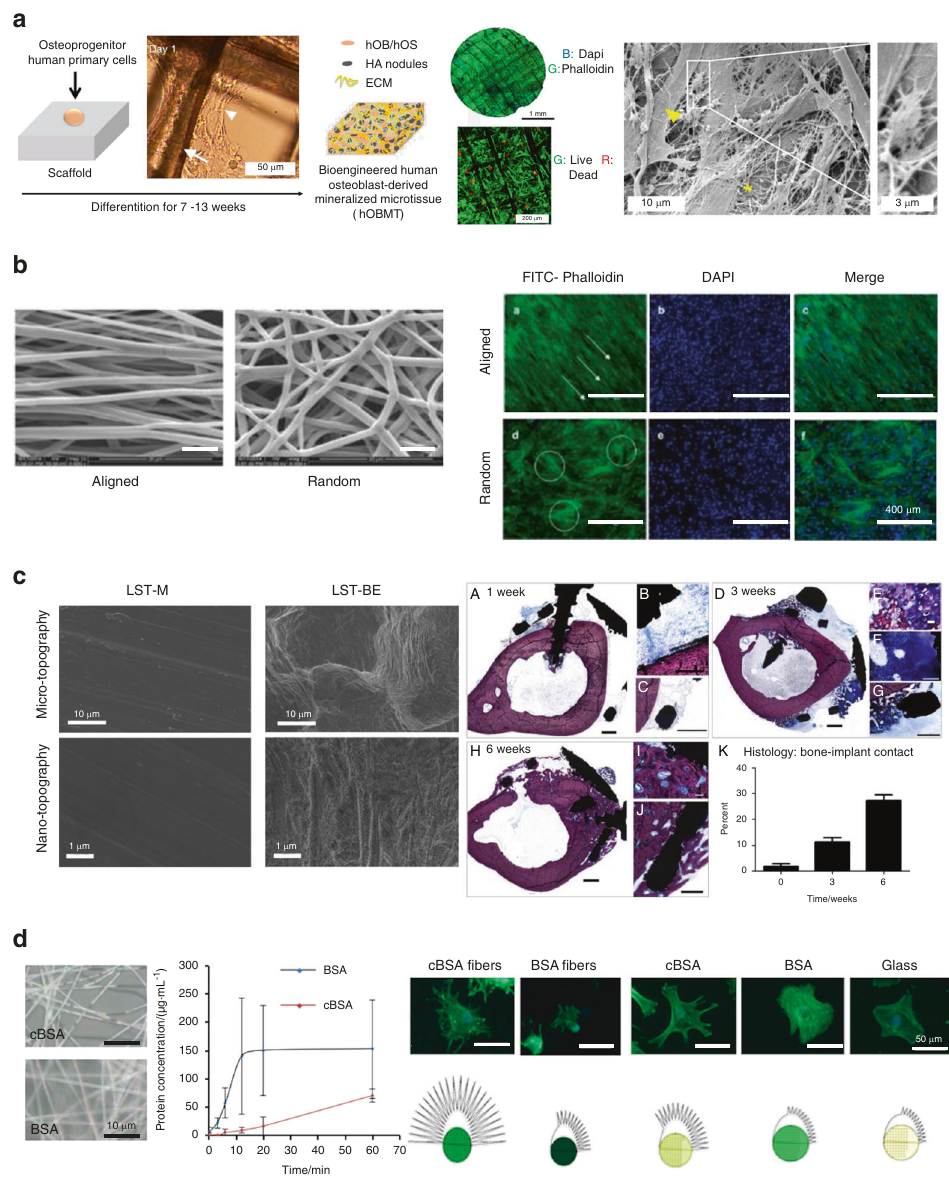
Fig. 4 Examples of smart biomaterials responding to intrinsic material properties and its response. a 3D printed medical-grade polycaprolactone (mPCL) scaffolds treated with calcium phosphate. Left panel: Schematic showing human primary osteoprogenitor cell seeding on treated mPCL scaffolds. The white arrow and the arrowhead show scaffold fi bers and cell organization, respectively. After 7 weeks, the cellular construct leads to the formation of a human osteoblast-derived mineralized microtissue (hOBMT). Middle panel: Staining of the hOBMT shows high cellular organization, strong directional orientation of the actin fi laments and >80% cell viability after 10 weeks in culture. Right panel: SEM imaging shows dense ECM deposition (asterisk), osteoblastic cells (arrowhead), and osteocytic cells (insert). 71 b Aligned fi brous polyurethane scaffolds used for culturing annulus fi brosus-derived stem/progenitor stem cells (AFSCs). Left panel: SEM images of the electrospun poly(ether carbonate urethane)- urea (PECUU) scaffolds with aligned and random fi brous microstructures. Right panel: Staining of the AFSCs shows the orientation of the cells along the fi bers in the aligned scaffolds while in the random scaffolds, the cells seem randomly oriented. 72 c Subperiosteal titanium-aluminum-vanadium bone onlay fabricated by additive manufacturing (AM) and with post-processing surface treatments. Left panel: Micro and nano topography for disks polished with aluminum oxide sanding paper (LST-M) and grit blasted and acid-etched surfaces (LST-BE). Right panel: Osseointegration was analyzed on surface-modi fi ed wrap implants placed around rabbit tibias. After 1 week of implantation, histological sections showed small gaps remaining between the implant screws and bone with new bone and connective tissue (A – C). After 3 weeks, additional bone growth was evident (D – G). At 6 weeks, fully formed bone was present in contact with the inside of the implant (H – J). 6 weeks after implantation, a higher bone-to-implant contact value was observed in histological sections compared to week 1 and 3 and to non-surface-modi fi ed constructs (K). 78 Scale bars for (A – D, H) represent 1mm, scale bars for (G) and (I) represent 500 μ m, scale bar for F represents 200 μ m, scale bar for (J) represents 100 μ m and scale bar for (E) represents 20 μ m. d Fibrous scaffold resembling the bone/bone marrow extracellular matrix (ECM) based on bovine serum albumin (BSA). Positive charges in the fi bers were introduced via cationization. Left panel: Electrospun fi ber morphology was characterized using microscopy (cBSA-cationized; BSA- naive, not cationized). Middle panel: The stability of the fi bers against proteases was studied by incubating the fi bers in a trypsin/EDTA solution. The cBSA- fi bers showed higher stability against proteases compared to the BSA- fi bers, as assessed by measuring the timedependent accumulation of BSA in the supernatant. Right panel: MSCs morphology on different substrates (cBSA- fi bers, BSA- fi bers, cBSA-coated glass, BSA-coated glass and untreated glass). The fl uorescent micrographs of cells cultured on cBSA- fi bers or cBSA-coated glass showed more and longer protrusions that are related to the regulation of three-dimensional cell migration. 92 Figures adapted with permission from refs.